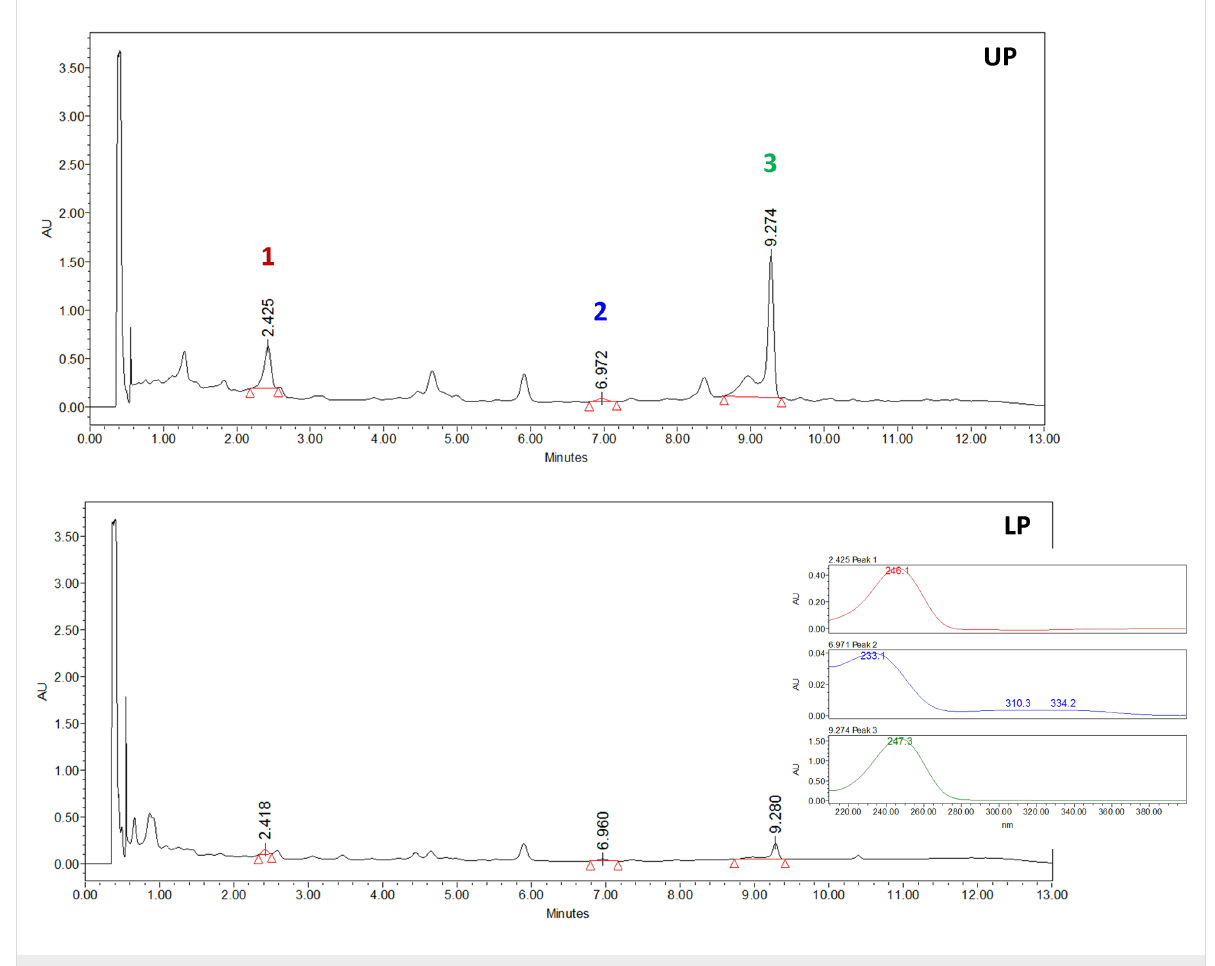
Figure 1: UPLC profile of the butanol fraction of the leaves of Jungia sellowii after shaking the flask with the selected biphasic system (details in the Experimental section). UP: upper phase (top chromatogram), LP: lower phase (bottom chromatogram). Detection at 242 nm.